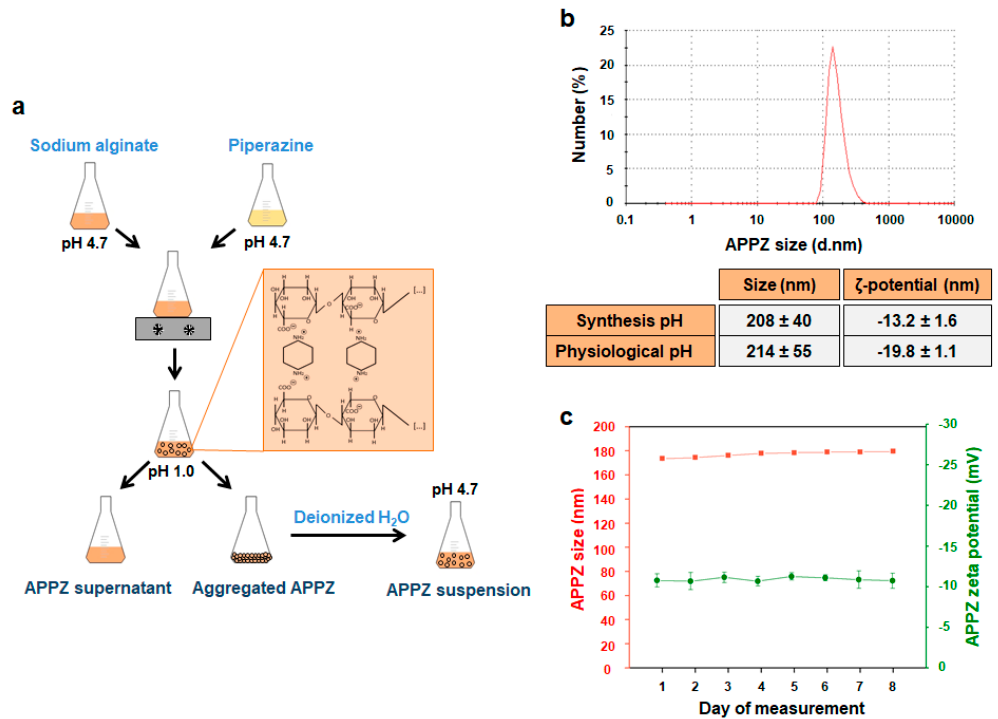
Figure 1. APPZ synthesis and characterization. ( a ) APPZ development. ( b ) APPZ size and a zeta potential at the synthesis (4.7) and physiological (7.2) pH values in deionized water and PBS, respectively. These parameters were determined by DLS and LDE as the mean ± SD of three measurements. The diagram corresponds to APPZ mean size at pH 4.7. ( c ) APPZ diameter and surface charge stability over 8 consecutive days. All the values are the mean ± SD of three measurements, too.